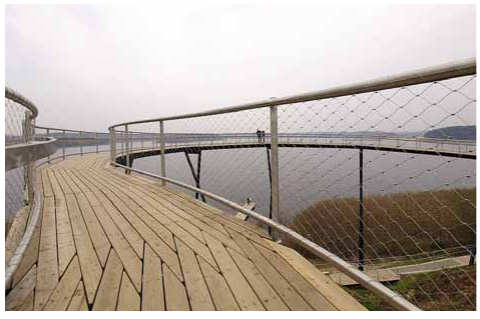
Fig. 45. Trench bridge in Halstern, Holland,